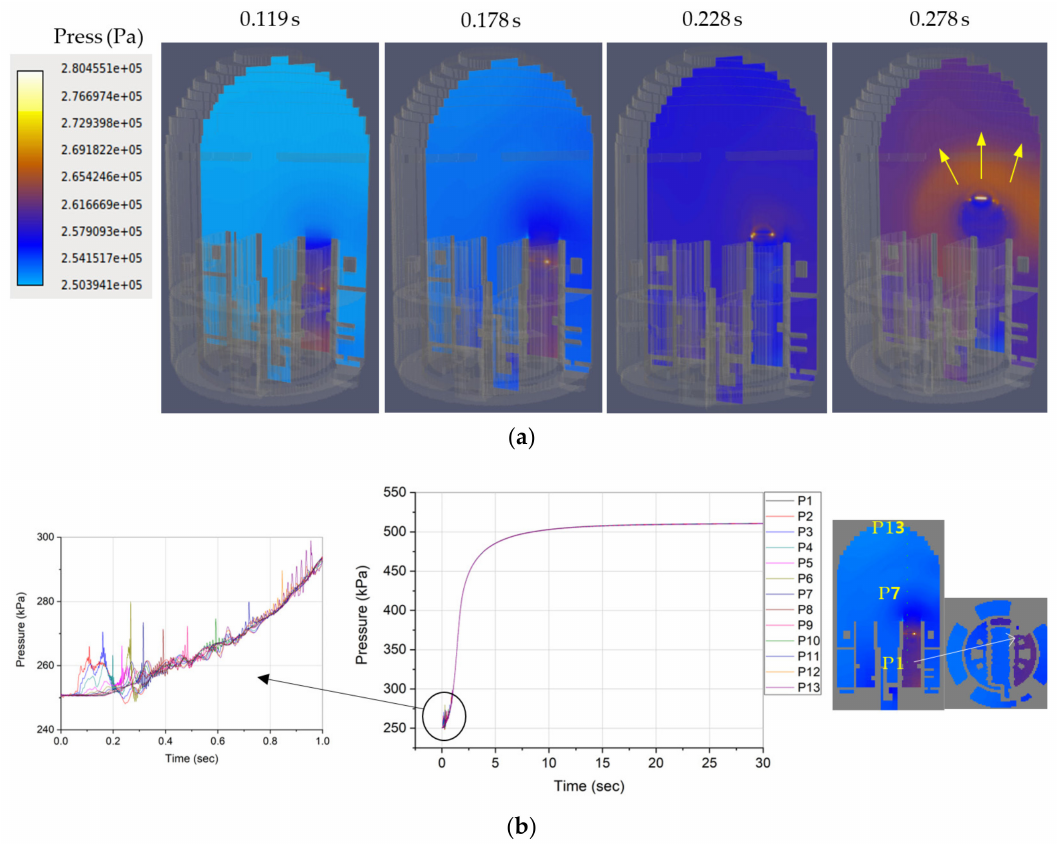
Figure 11. Predicted pressure for the hydrogen flame acceleration by COM3D. ( a ) Pressure distributions as time passes. ( b ) Pressure behavior from P1 to